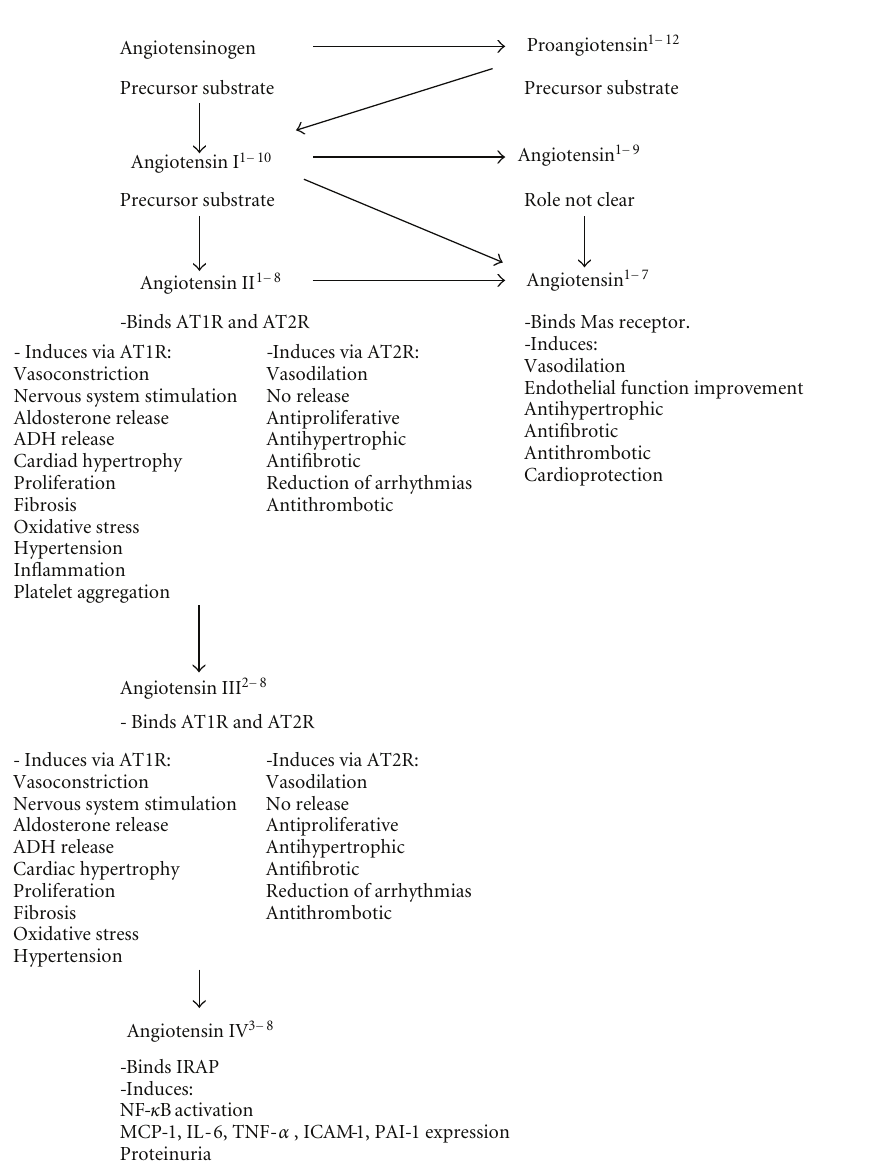
Figure 3: Revisited functions of the renin-angiotensin axis. Recent studies support that angiotensins influence several processes, including inflammation. AT 1 R: angiotensin type 1 receptor; AT 2 R: angiotensin type 2 receptor; IRAP: insulin-regulated aminopeptidase; Mas (mas oncogene)